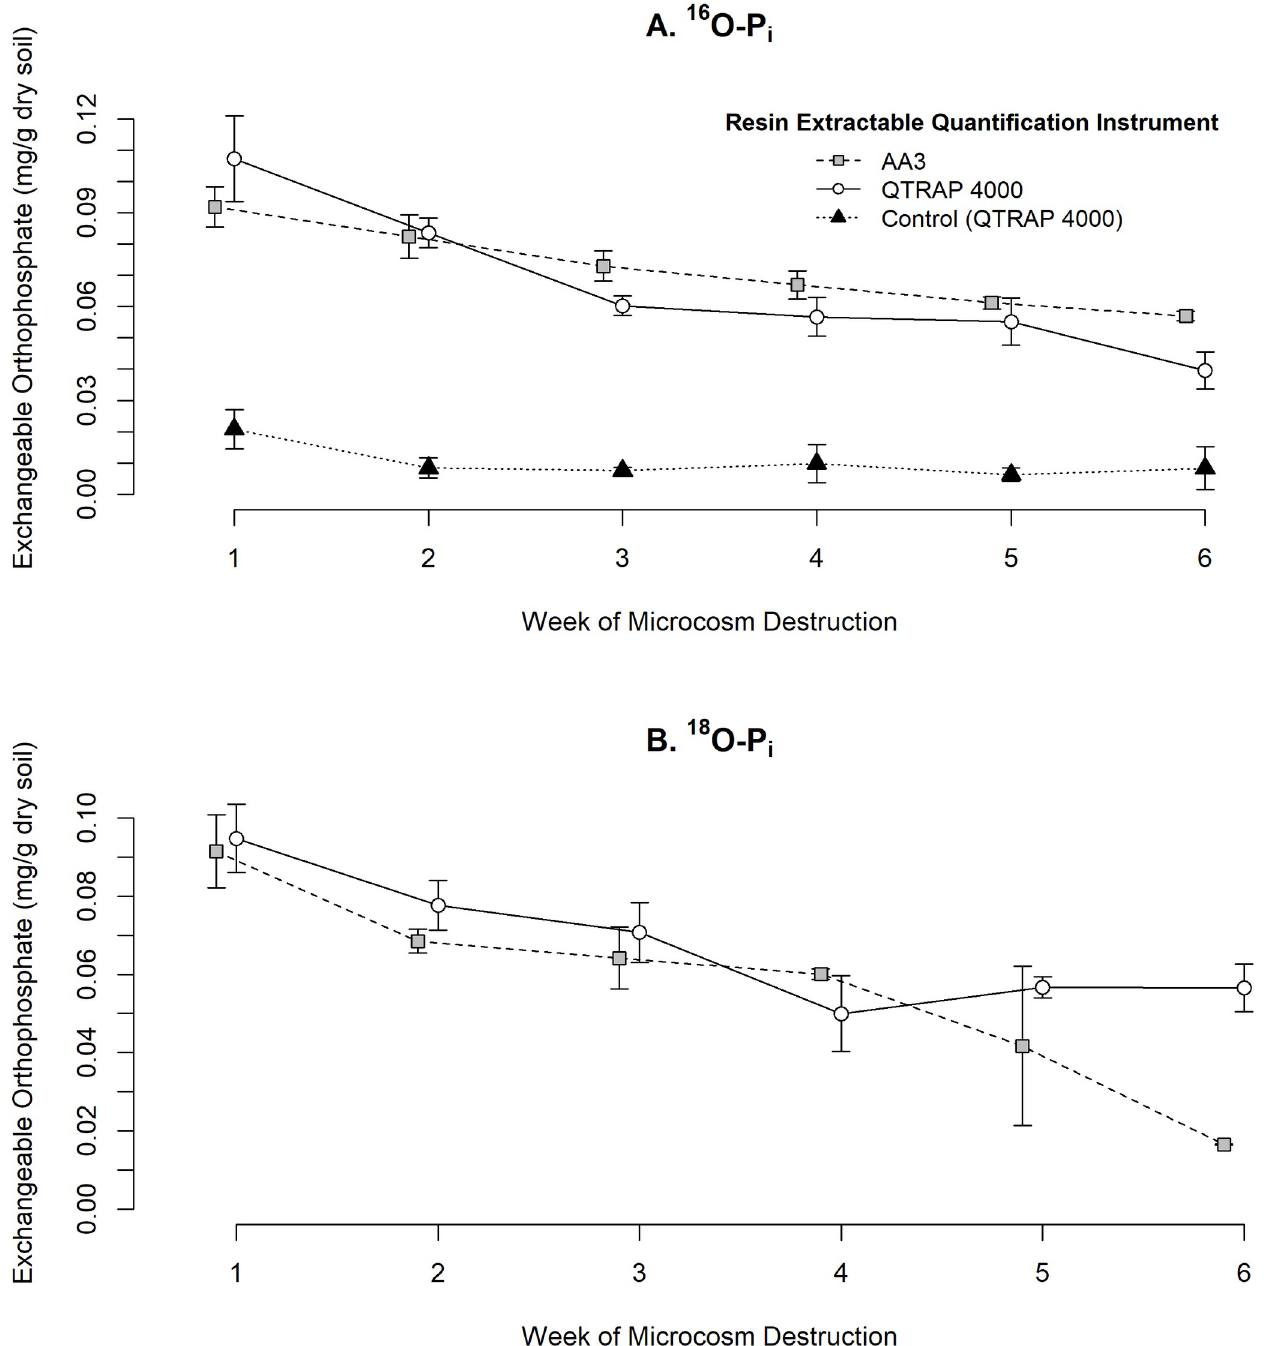
Fig 1. Concentration of resin-extractable P i measured by AA3 and QTRAP 4000 versus week of microcosm destruction. At each time point, 0.5 g of soils were dried, sieved, and analyzed using strong anion resin strips. Each symbol represents the average of 4 microcosms ± standard errors of the estimates. Some symbols were offset on the x-axis to visualize the differences between treatment means. (A) The concentration of exchangeable 16 O- P i from 16 O- P i doped microcosms. (B) 18 O- P i concentrations from 18 O- P i doped